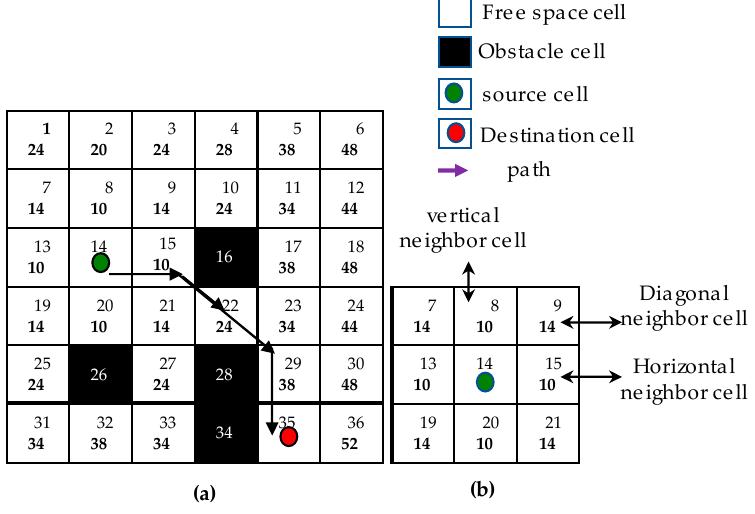
Figure 7. A-star shortest path searching. ( a ) Estimating A-star path, ( b ) neighboring cells.